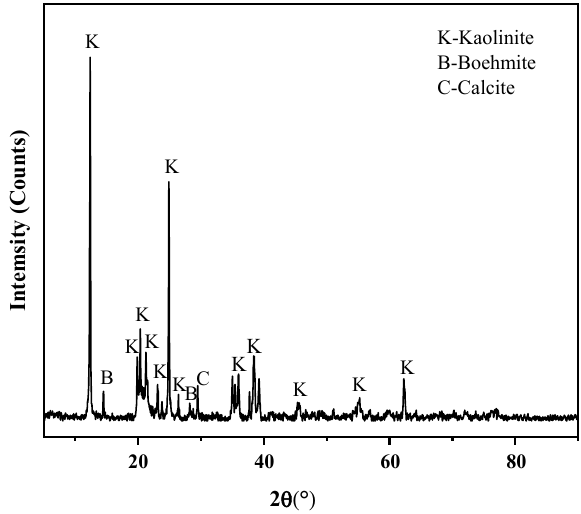
Figure 2. XRD pattern of raw coal gangue. Table 3. The content of major chemical compositions and critical elements in coal gangue sample.